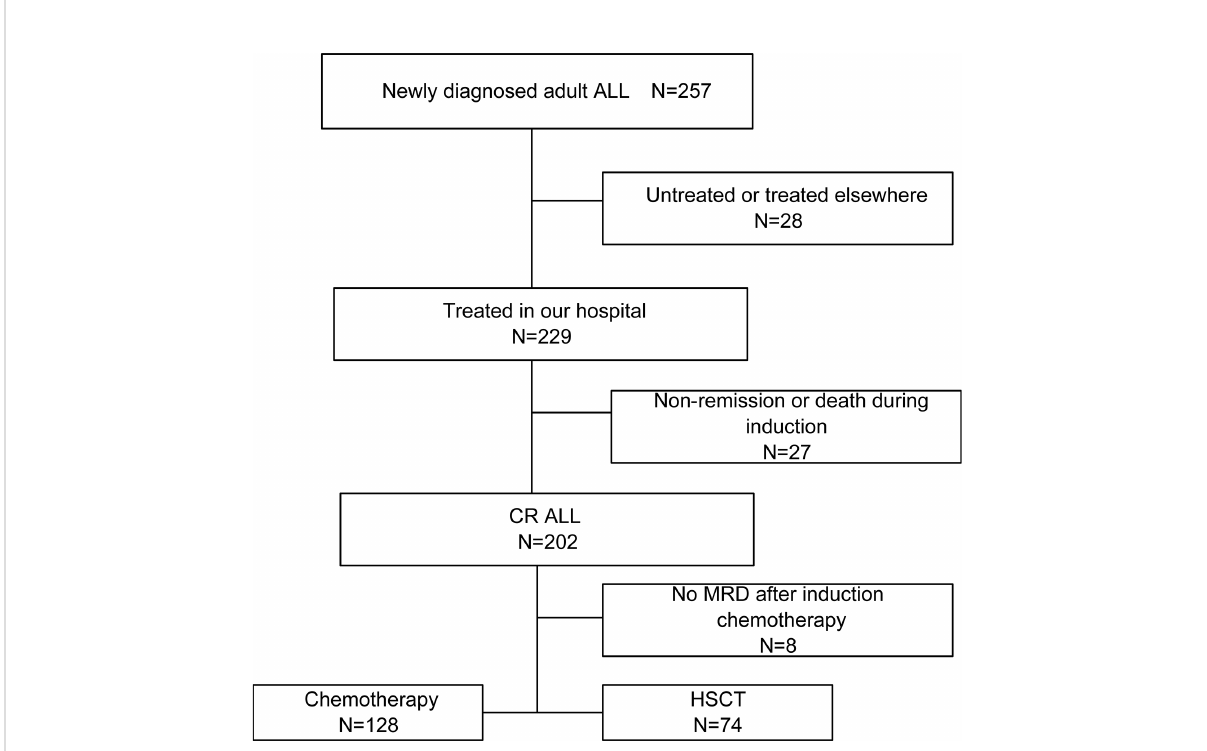
FIGURE 1 An overview fl owchart containing ALL patients ’ recruitment and exclusion. ALL, acute lymphoblastic leukemia; CR, complete remission; HSCT, hematopoietic stem cell